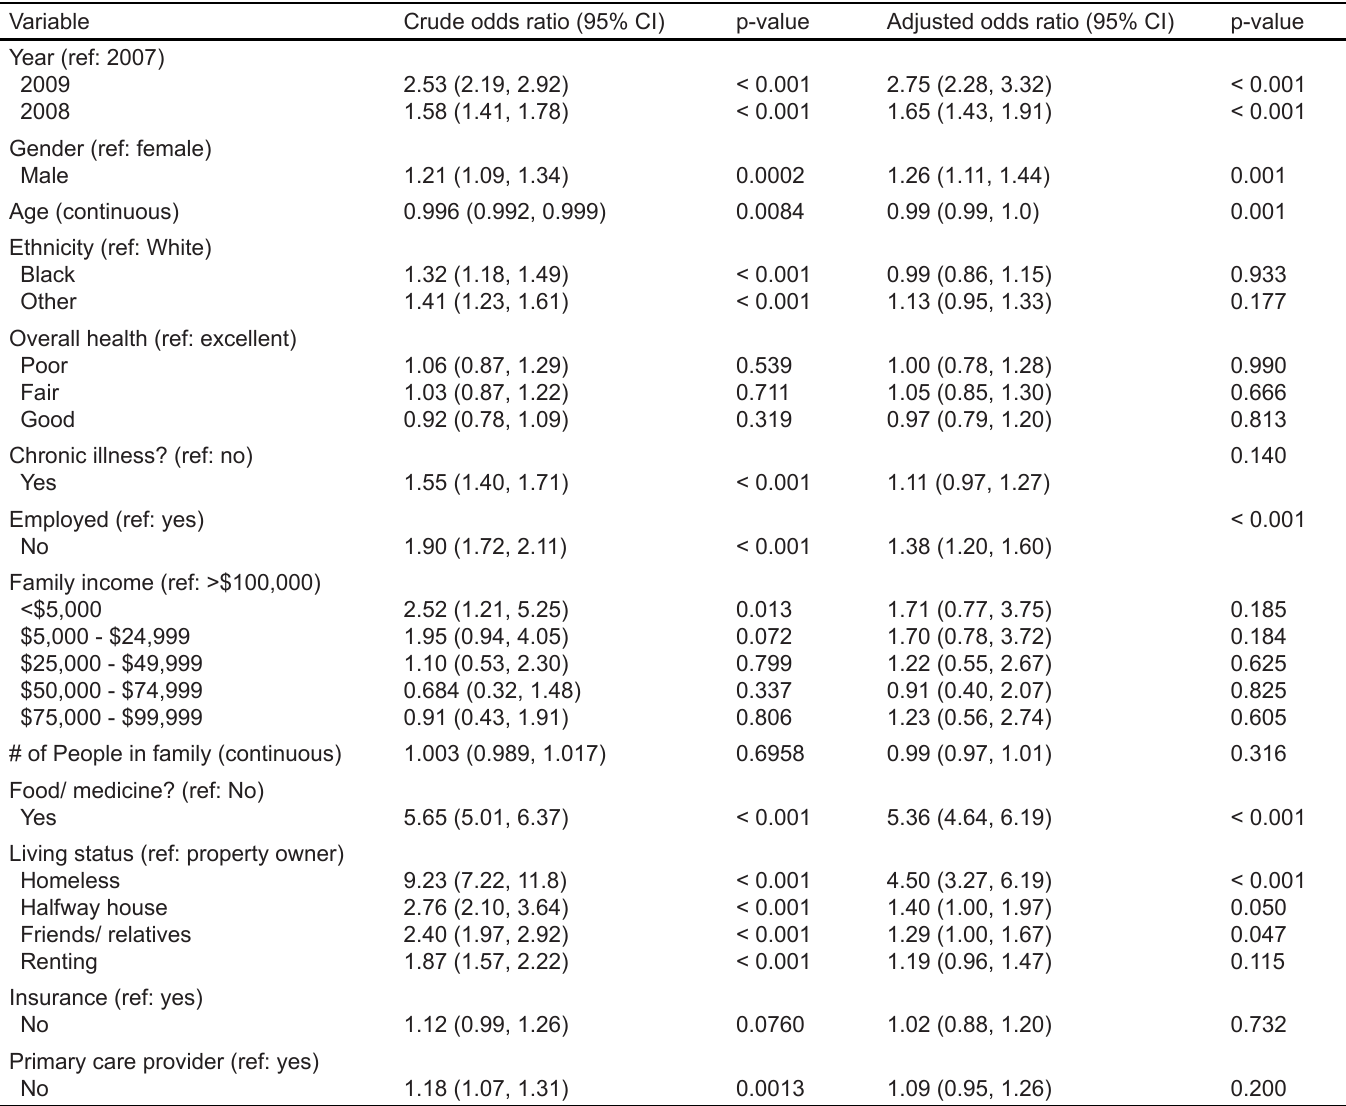
Table 6. Logistic model-characteristics associated with